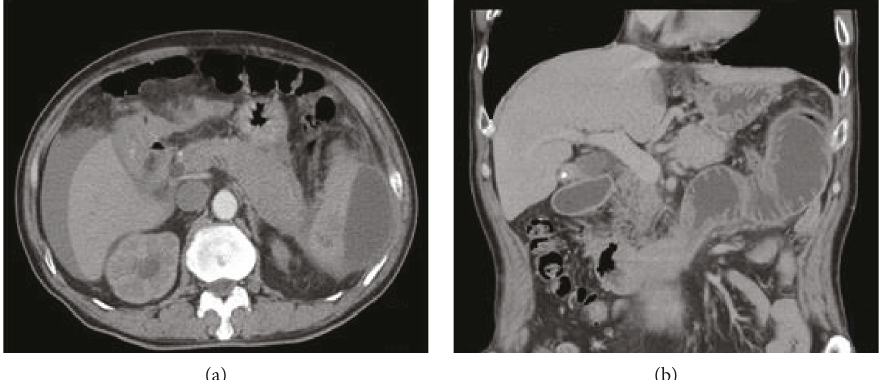
Figure 2: CT scan of patient no. 4. (a) Axial section of the CT scan showed a hematoma in the lower pole and lateral spleen area combined with the enlargement of the body and tail of the pancreas and free fl uid around the liver and spleen. (b) Coronal section of the CT scan showed an obstruction of the small